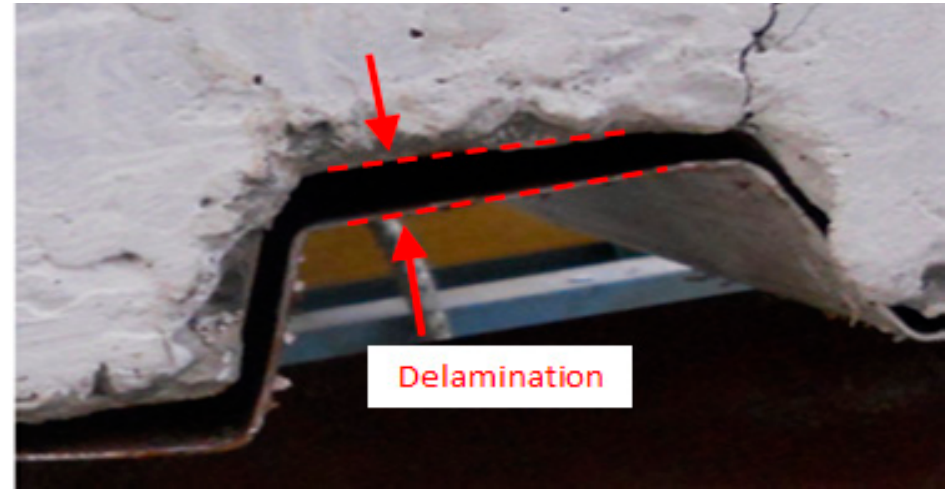
Figure 13. Debonding failure of trapezoidal profiled composite slab.